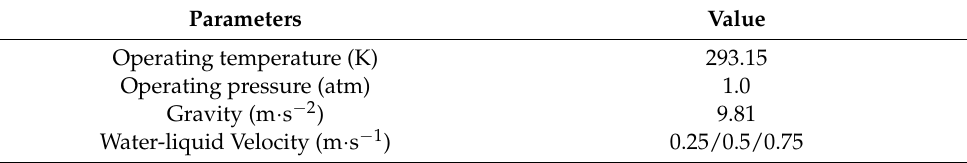
Table 1. Operating Table 1. Operating parameters.